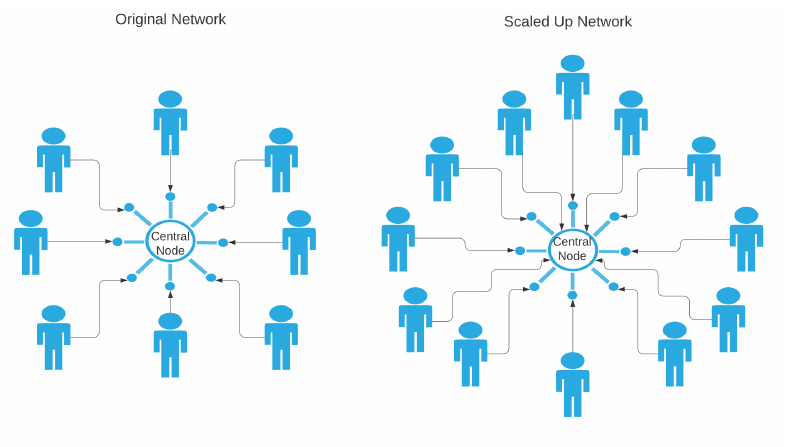
Figure 3. In a centralized network, a small percentage of the nodes handle a bulk of the work. To scale such a network, the primary nodes need to increase their ability to handle more